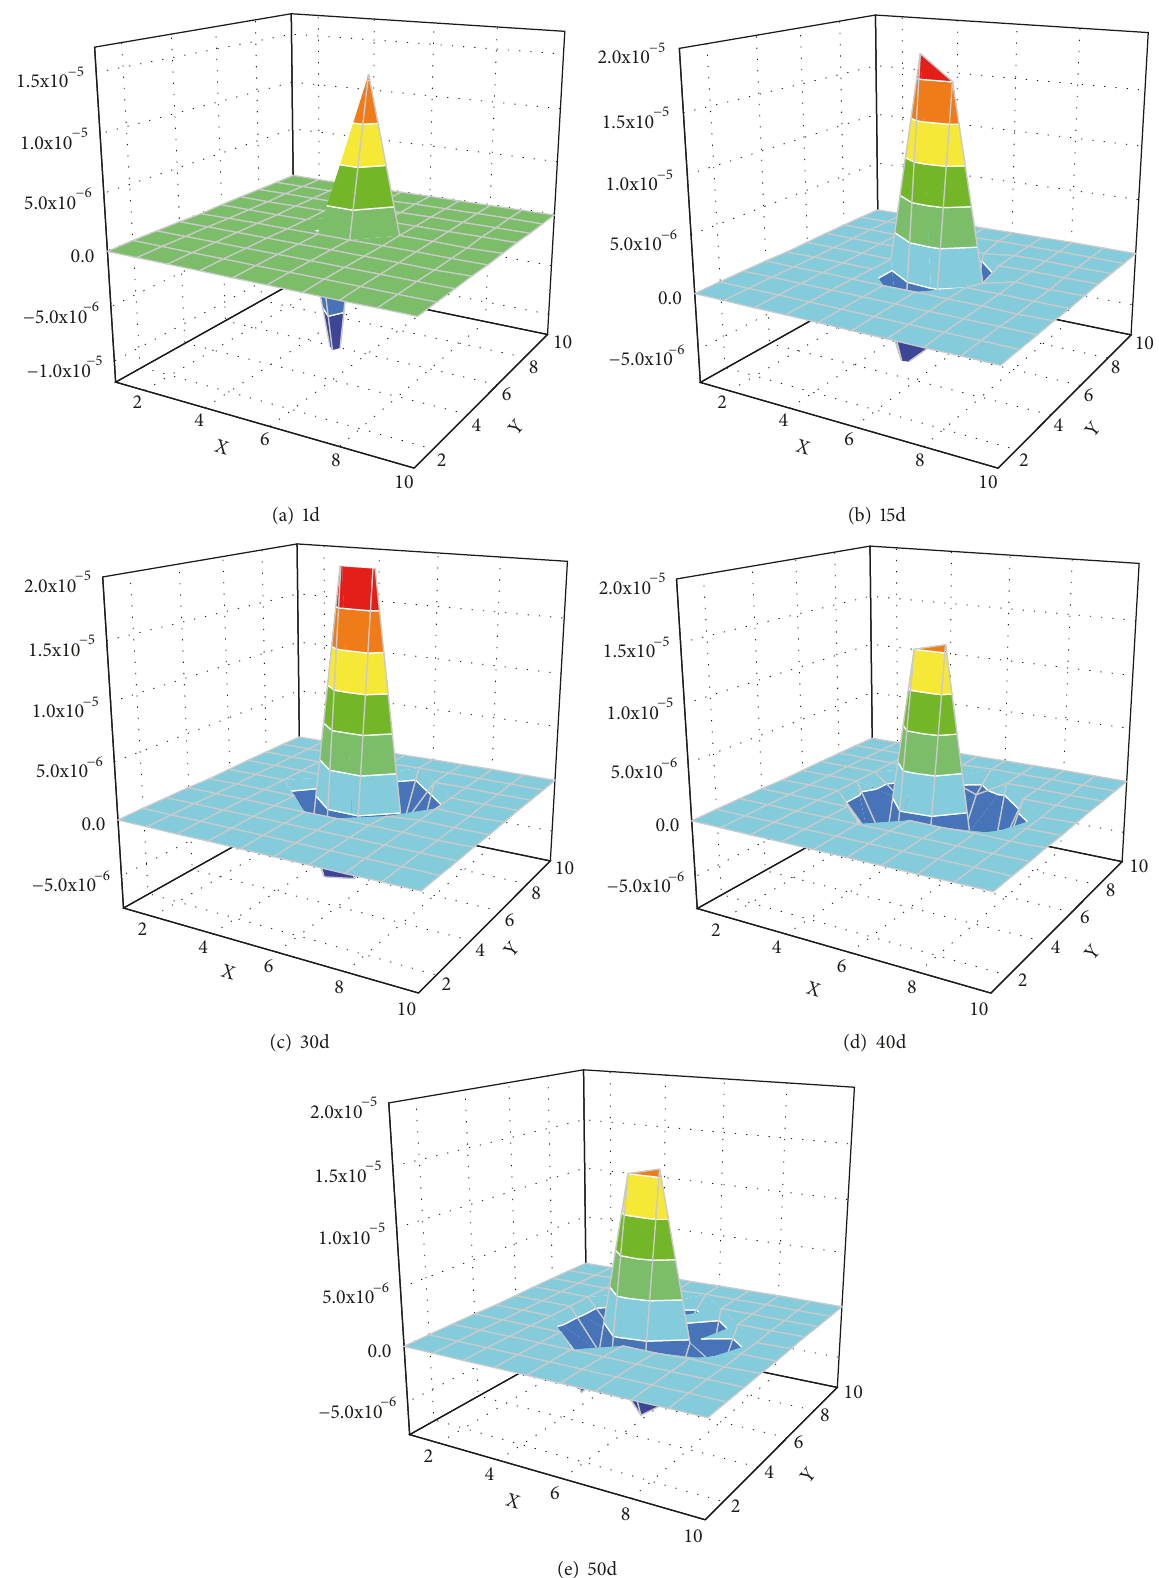
Figure 4: The current density distribution of the scratch system is immersed in a 3.5% NaCl solution for different